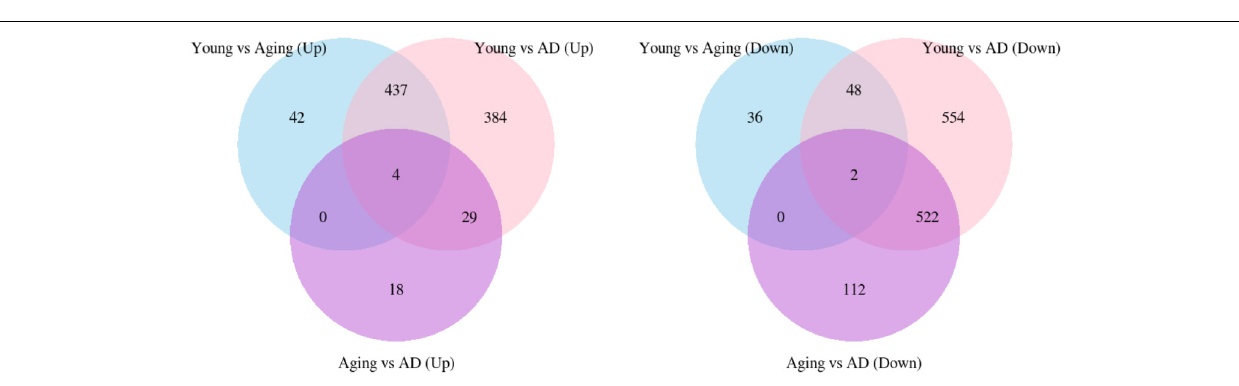
spliceosome, and RNA transport. A key hub gene of the module M2 is TFEB, PAN2, and